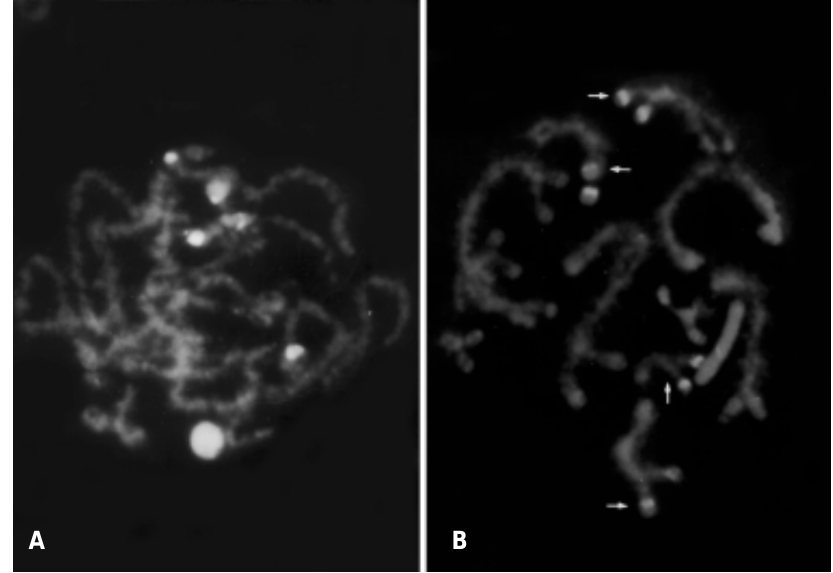
Figure 3 - CMA the pericentromeric regions of M